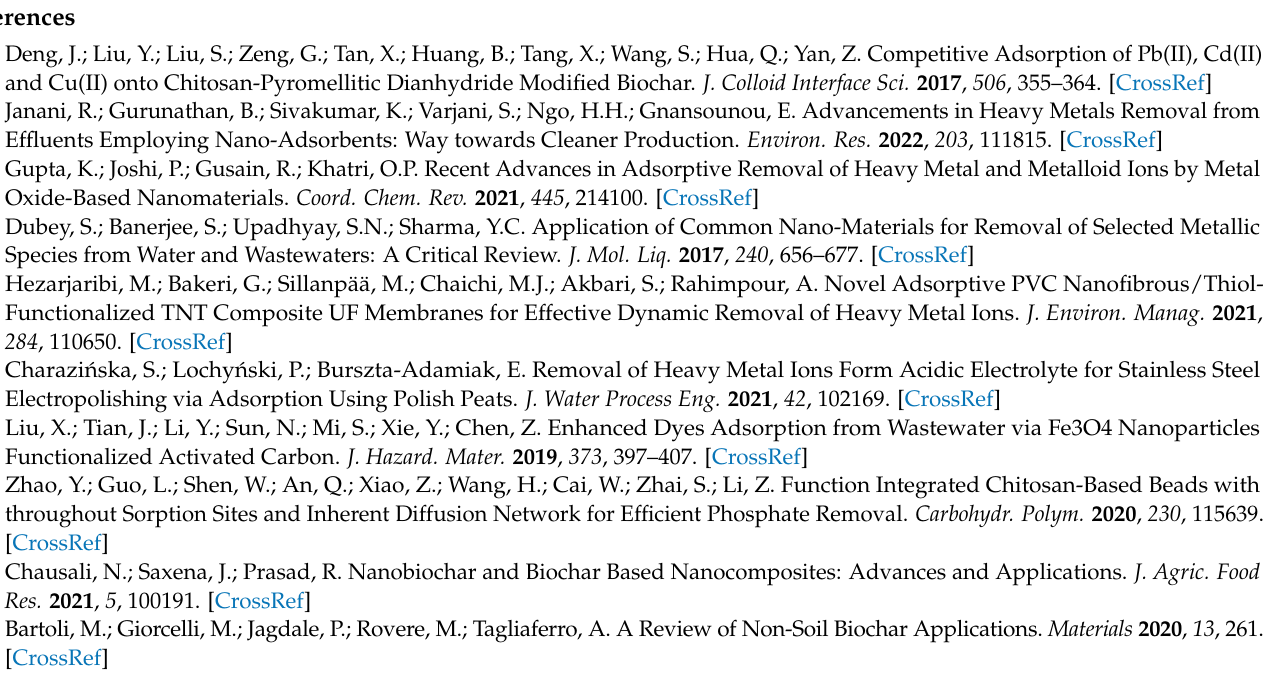
Table S2: Parameters for various adsorption kinetic models for Cu(II), Cd(II), Zn(II) Co(II) and Pb(II) sorption on BC-CS 4-1; Table S3: Adsorption isotherm parameters and correlation coefficients for the adsorption of Cu(II), Cd(II), Zn(II), Co(II) and Pb(II) on BC-CS 2-1; Table S4: Adsorption isotherm parameters and correlation coefficients for the adsorption of Cu(II), Cd(II), Zn(II), Co(II) and Pb(II) on BC-CS 4-1; Table S5: Thermodynamic parameters for the sorption of Cu(II), Cd(II), Zn(II), Co(II) and Pb(II) ions on BC-CS 2-1; Table S6: Thermodynamic parameters for the sorption of Cu(II), Cd(II), Zn(II), Co(II) and Pb(II) ions on BC-CS